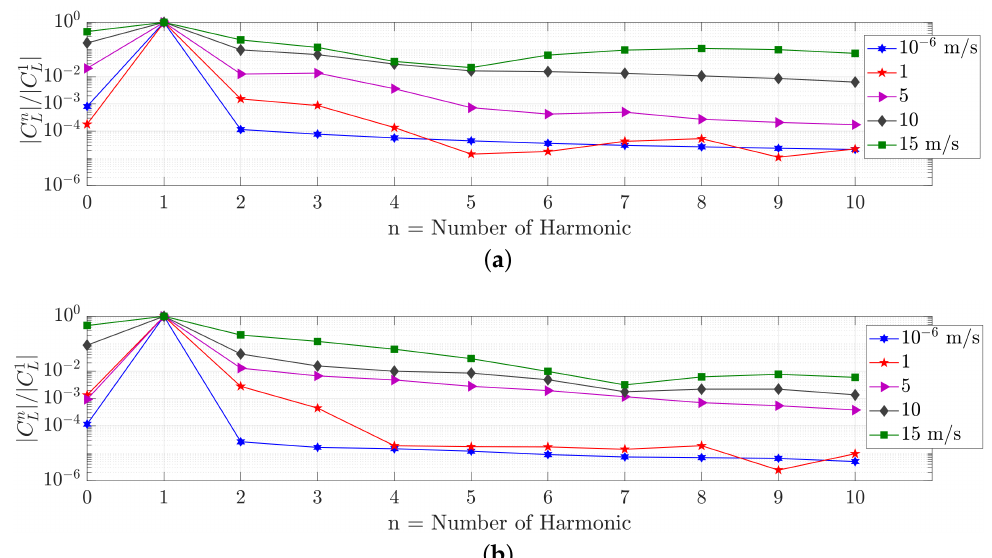
Figure 7. Normalized frequency content of the lift coefficient. ( a ) L G = 125.5 m (k = 0.05), ( b ) L G = 31.5 m (k =